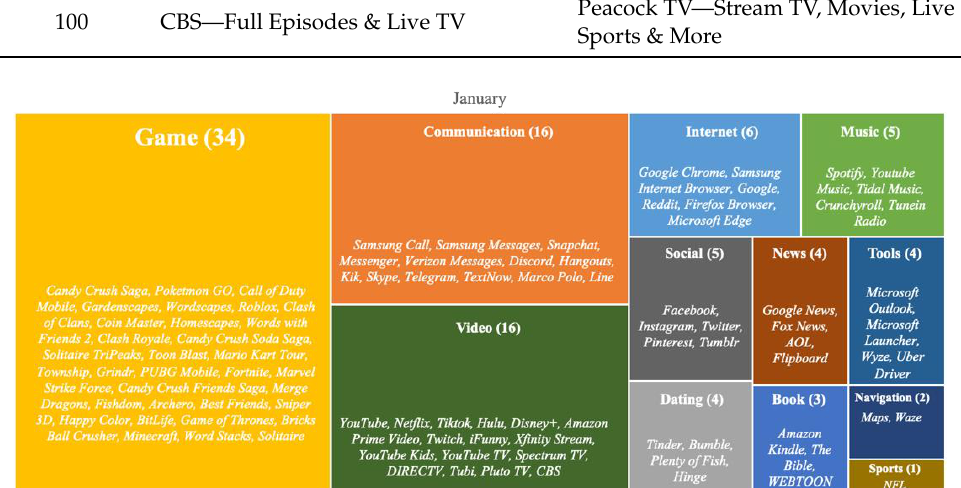
Figure 3. Method to determine the top-n applications.